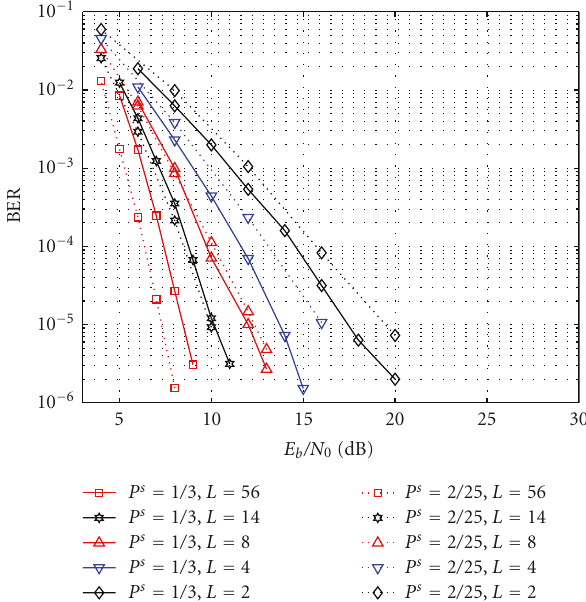
Figure 14: Performance comparison between the two power allocation schemes with source-destination